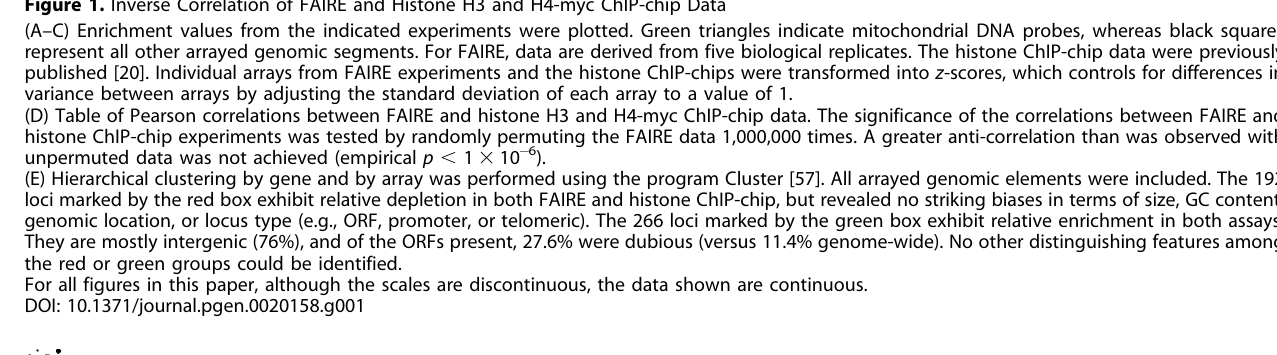
Figure 1. Inverse Correlation of FAIRE and Histone H3 and H4-myc ChIP-chip Data (A–C) Enrichment values from the indicated experiments were plotted. Green triangles indicate mitochondrial DNA probes, whereas black squares represent all other arrayed genomic segments. For FAIRE, data are derived from five biological replicates. The histone ChIP-chip data were previously published [20]. Individual arrays from FAIRE experiments and the histone ChIP-chips were transformed into z -scores, which controls for differences in variance between arrays by adjusting the standard deviation of each array to a value of 1. (D) Table of Pearson correlations between FAIRE and histone H3 and H4-myc ChIP-chip data. The significance of the correlations between FAIRE and histone ChIP-chip experiments was tested by randomly permuting the FAIRE data 1,000,000 times. A greater anti-correlation than was observed with unpermuted data was not achieved (empirical p , 1 3 10 (cid:1) 6 ). (E) Hierarchical clustering by gene and by array was performed using the program Cluster [57]. All arrayed genomic elements were included. The 192 loci marked by the red box exhibit relative depletion in both FAIRE and histone ChIP-chip, but revealed no striking biases in terms of size, GC content, genomic location, or locus type (e.g., ORF, promoter, or telomeric). The 266 loci marked by the green box exhibit relative enrichment in both assays. They are mostly intergenic (76%), and of the ORFs present, 27.6% were dubious (versus 11.4% genome-wide). No other distinguishing features among the red or green groups could be identified. For all figures in this paper, although the scales are discontinuous, the data shown are continuous. DOI: 10.1371/journal.pgen.0020158.g001 PLoS Genetics |